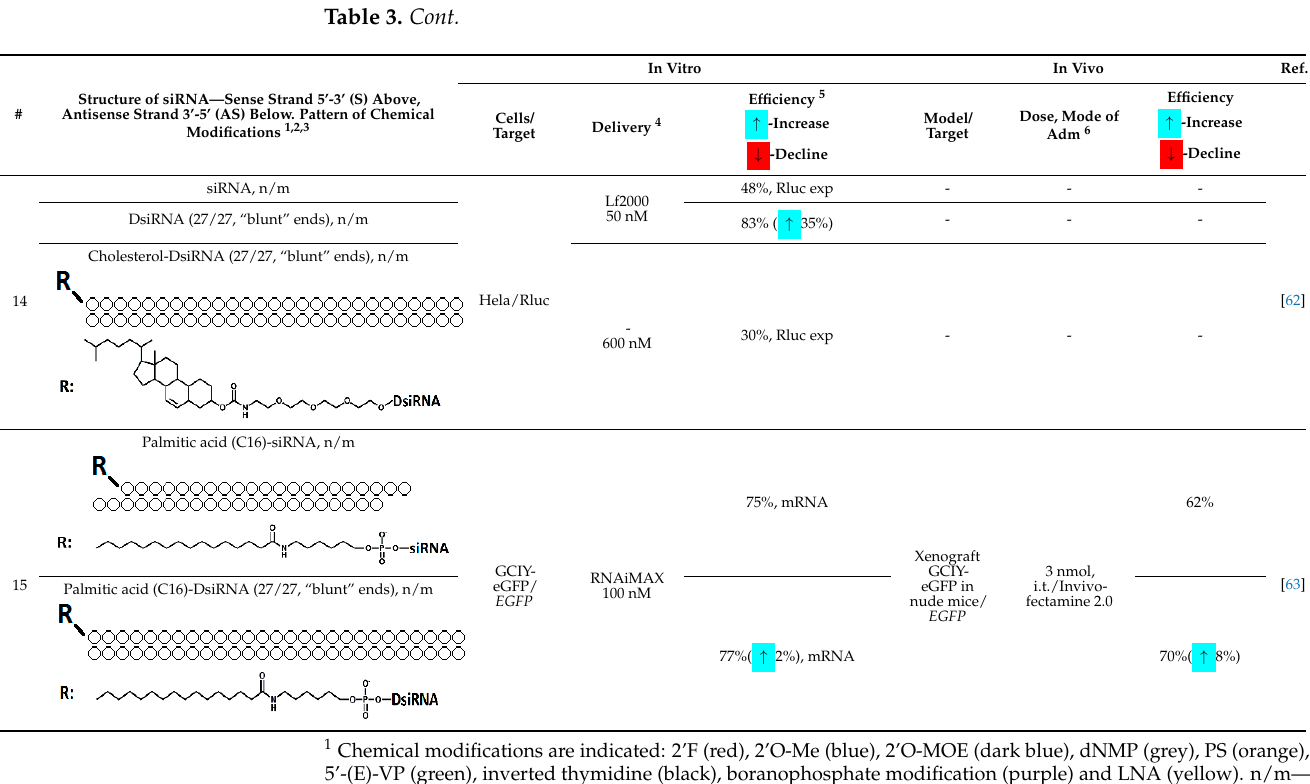
1 Chemical modifications are indicated: 2’F (red), 2’O-Me (blue), 2’O-MOE (dark blue), dNMP (grey), PS (orange), 5’-(E)-VP (green), inverted thymidine (black), boranophosphate modification (purple) and LNA (yellow). n/m—non-modified. 2 “R”—linker with ligand. 3 Putative Dicer cleav- age sites are indicated by black arrows. 4 “-”—delivery without transfection agent, Lf2000—trans- fection agent Lipofectamine 2000. 5 Route of administration: i.v.—intravenously, s.c.—subcutane-